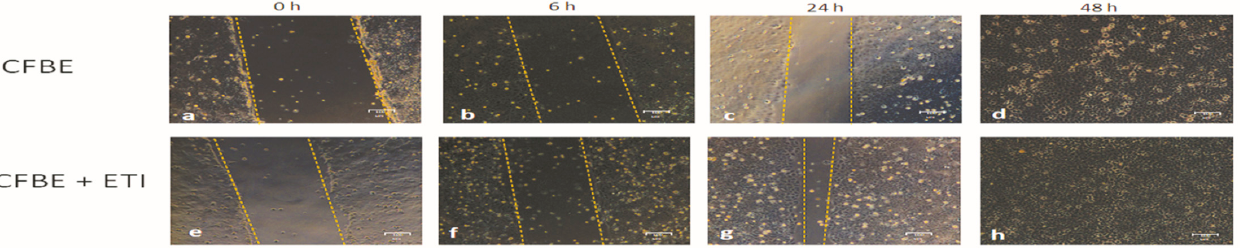
Figure 3. Wound size and wound healing rates in the presence of elexacaftor/tezacaftor/ivacaftor (ETI). ( A ) Percentage of wound size after 6, 24 and 48 h. Data are represented as a percentage of the initial area of the wound (t0) considered 100%. ** p < 0.01 and *** p < 0.001 CFBE-F508del + ETI vs. CFBE-F508del at 6 and 24 h, respectively ( n = 3). ( B ) Comparison of wound closure rates post wounding ( n = 3). * p < 0.05; *** p < 0.001. Data are shown as mean ± SD. 4. Discussion Nowadays, the personalized treatment of CF patients is proceeding at an unprece- dented pace due to the introduction of therapeutic drugs called CFTR modulators. These drugs can be used to treat nearly 90% of CF patients, including the CFTR potentiator iva- caftor, approved for residual function mutations (Classes III and IV), and combinations of